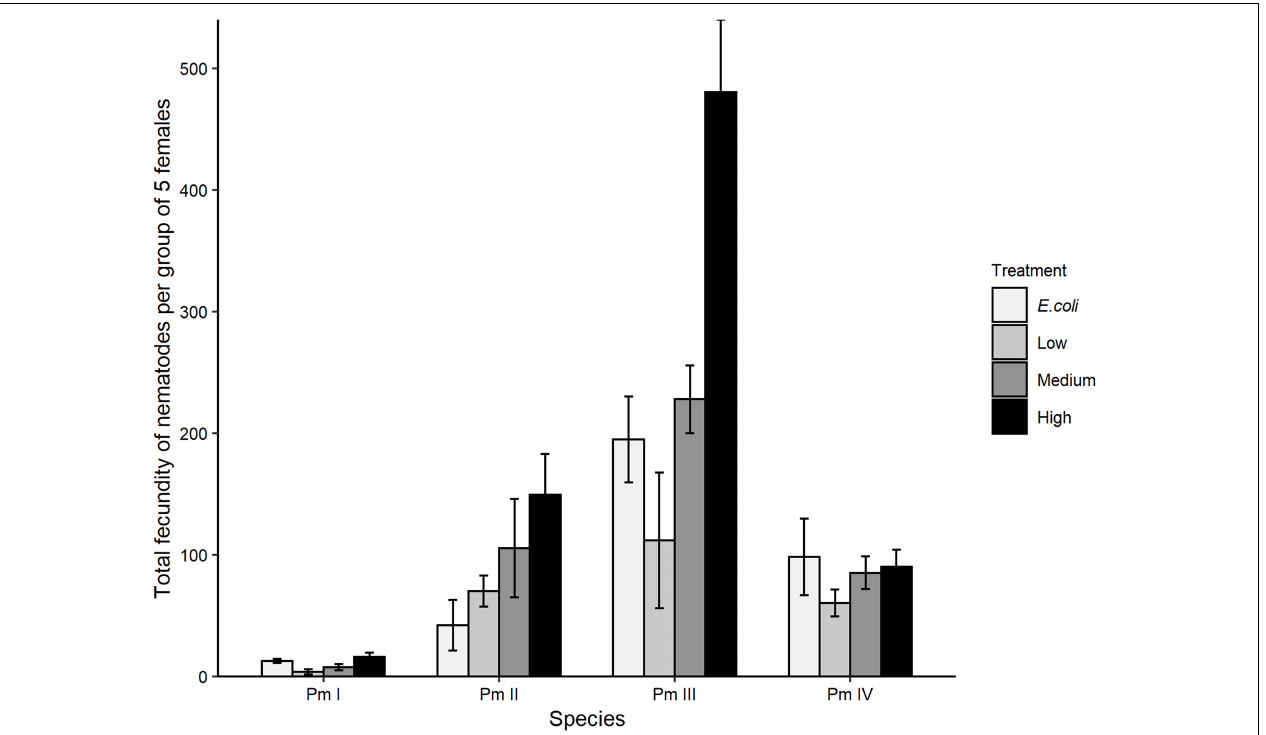
FIGURE 5 | Total fecundity: total number of offspring (eggs + juveniles) produced over the interval from the start of the incubation to the maturation of the first F1-offspring to adults (mean ± SE) for the four cryptic species of L. marina in different food treatments ( E. coli , low diversity, medium diversity, and high diversity) ( n = 4).